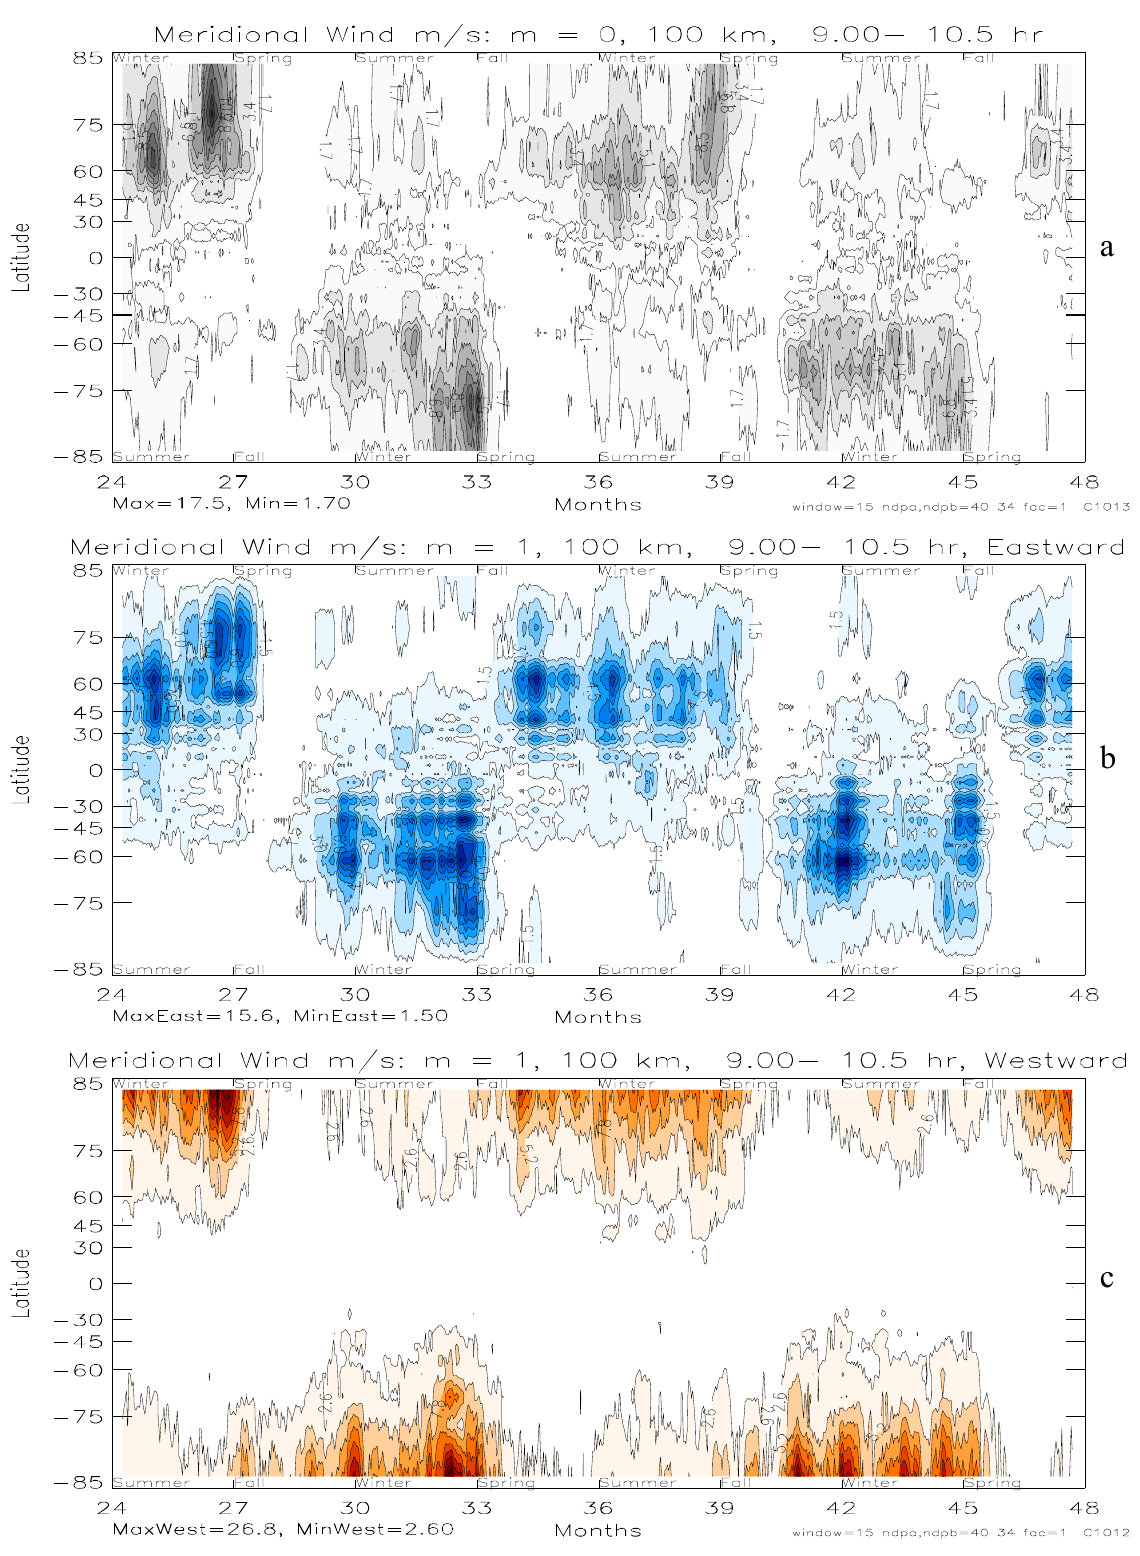
Fig. 8. To characterize the seasonal and latitudinal variations in the meridional winds at 100km, wave amplitudes are presented for the stationary waves with m=0 ( a ) , and the eastward ( b ) and westward ( c ) propagating m=1 components. For periods between 9 and 10.5h, a moving window of 15 days is applied. Maximum (and minimum) amplitudes (m/s) are stated, i.e. 17.5 (a), 15.6 (b) and 26.8 ( c )